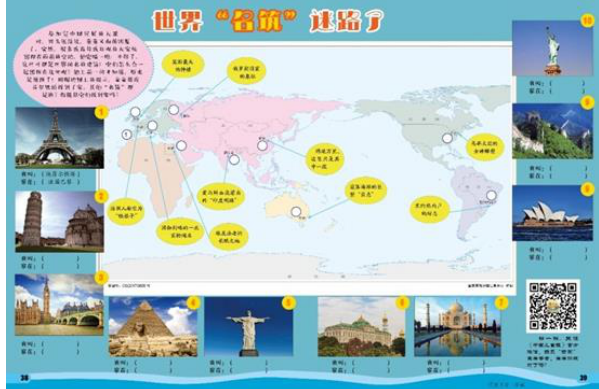
Figure 2. The world's "building" lost its way